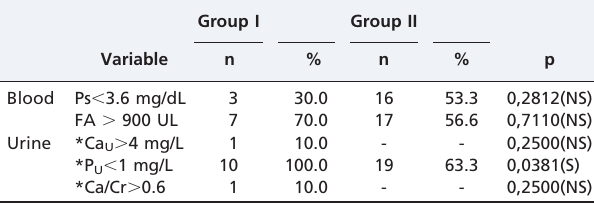
Table 2 - Serum and urinary values of Ca, P, FA, and Ca/Cr ratio in GI (n= 10) and in GII (n=